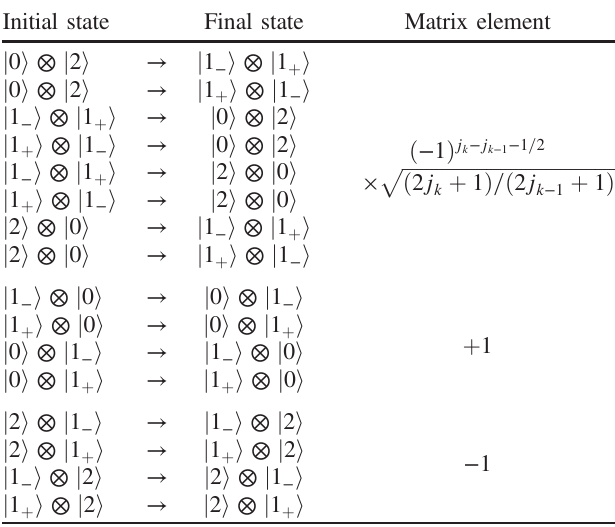
TABLE II. Gauge-invariant transitions induced by the hopping term from Fig. 1(c) expressed in the new basis. The value on the right-hand side shows the corresponding matrix elements for the hopping